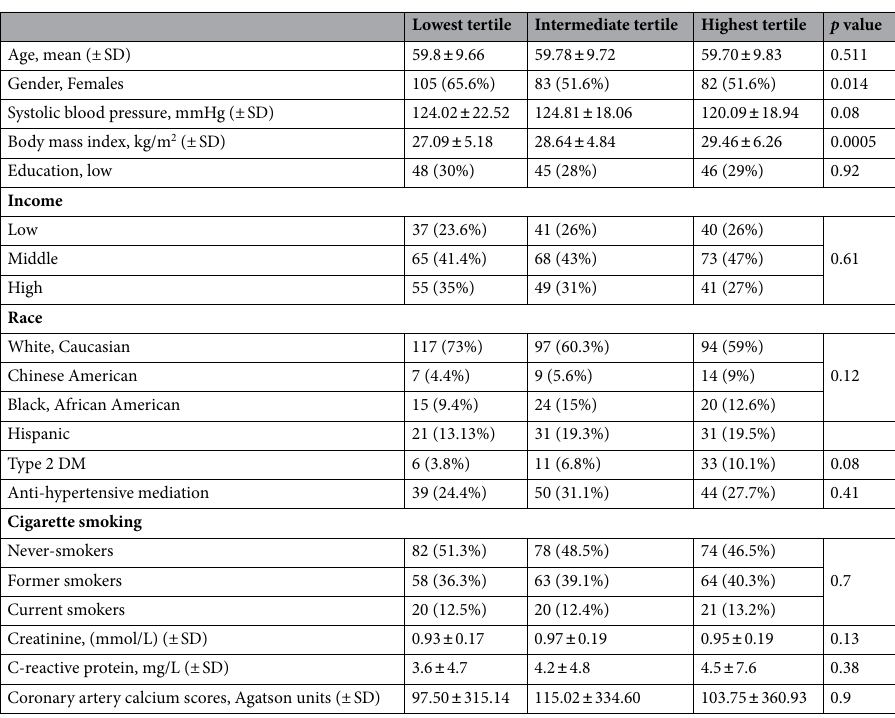
Table 4 . Characteristics of the MESA study population stratified by Podocin Tertiles.